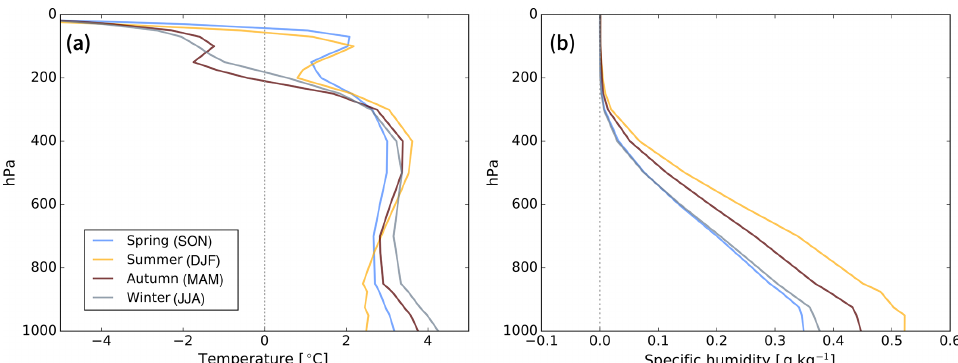
Figure 1. (a) Temperature and (b) specific humidity vertical profiles of the CMIP5-MMM anomaly (2080–2100 minus 1989–2009) that is added to ERA-Interim, here spatially averaged over West Antarctica (60–85 ◦ S, 170–40 ◦ W).